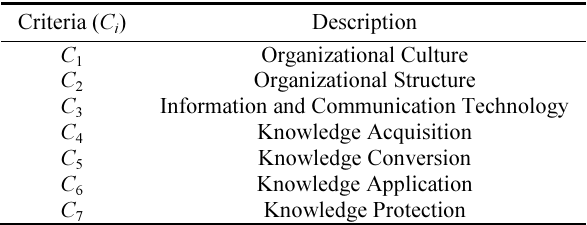
Table 1. Knowledge management practices ( C i